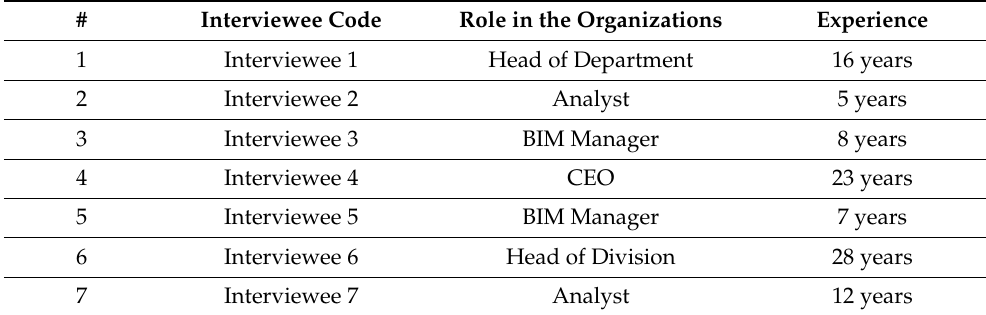
Table 2. Profile of